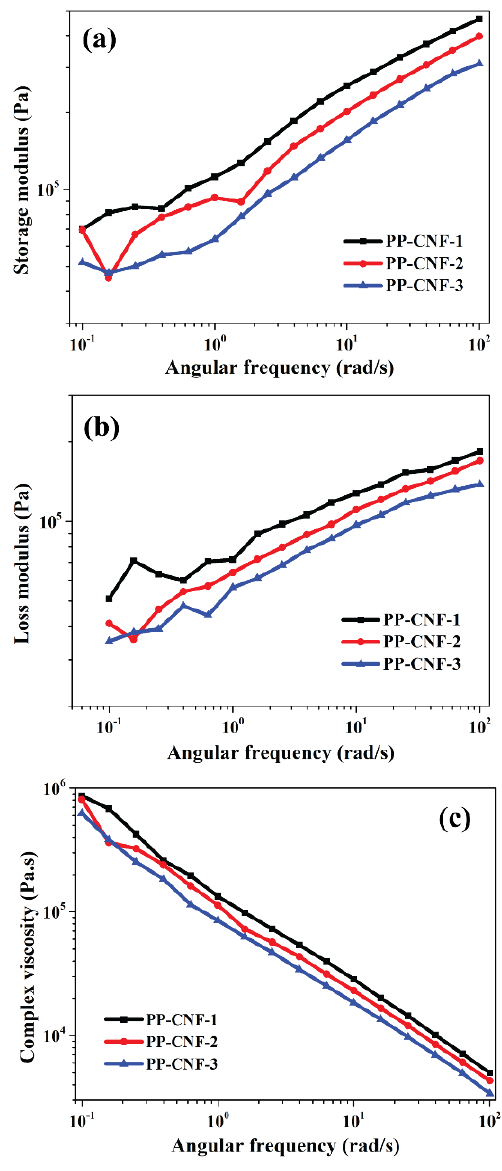
Figure 9. Variation of ( a ) storage modulus (G ′ ), ( b ) loss modulus (G ″ ), and ( c ) Complex viscosity ( η *) of recycled PP-CNF nanocomposites with frequency sweep with varying no. of recycling at 200 °C. TGA and DTA are used to find the nanocomposite’s degradation and the CNF content (Figure 10). By comparing the wt% loss as a function of increasing temperature, the effect of recycling on the thermal stability of PP nanocomposite has been analyzed. In all the specimens, the approximate weight left is around 30% CNF in the nanocomposite. Hence, TGA verifies the CNF content, which is the same in all the specimens. It also inferred that CNF is thermally stable at higher temperatures, and no weight loss in CNF is observed in every sample [4]. DTA calculates thermal degradation temperature, showing two significant peaks; one is associated with the removal of volatile content from the sample, and the other is the degradation of PP polymer in the nanocomposite. The degradation temperature is not primarily affected by polymer recycling, and the degradation temperature of 479.1, 475.6, and 480.3 ◦ C is reported for PP-CNF-1, PP-CNF-2, and PP-CNF-3,